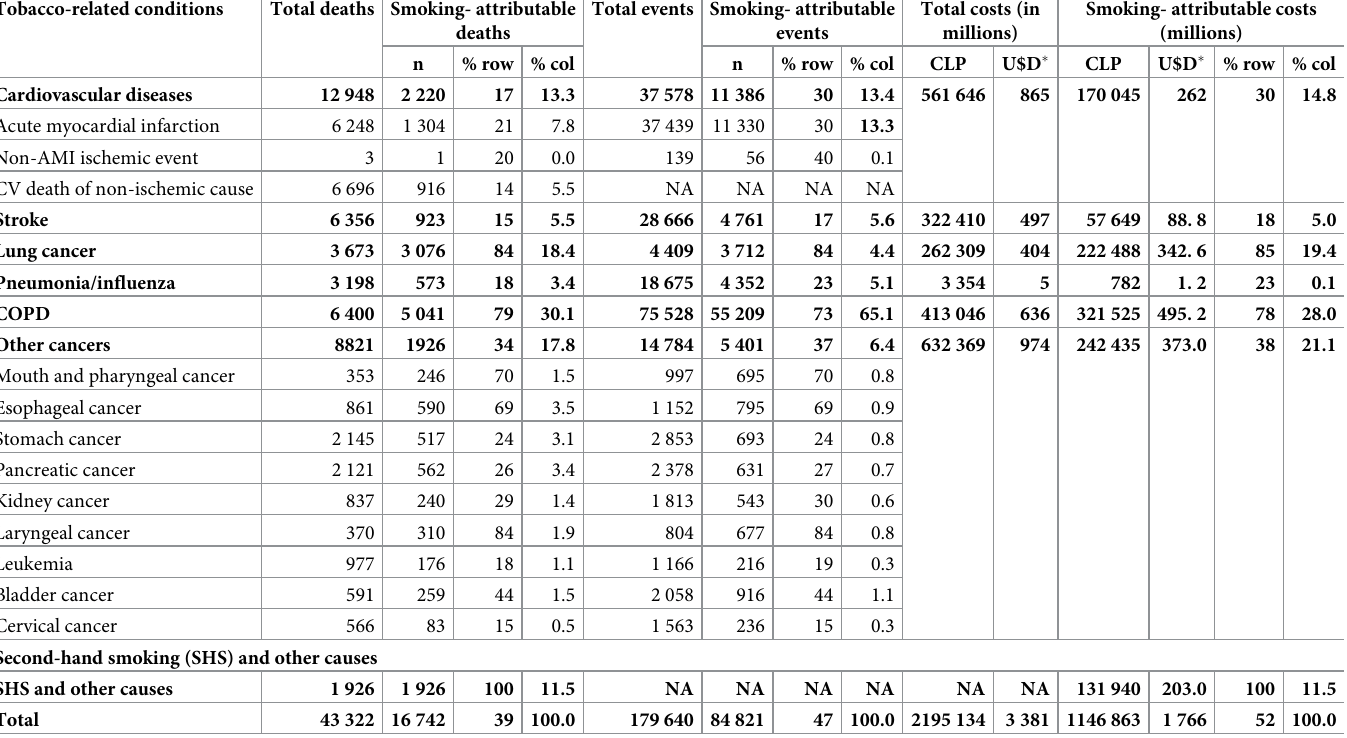
Table 5. Smoking-attributable deaths, events, and directs costs for the healthcare system for 2017. Tobacco-related conditions